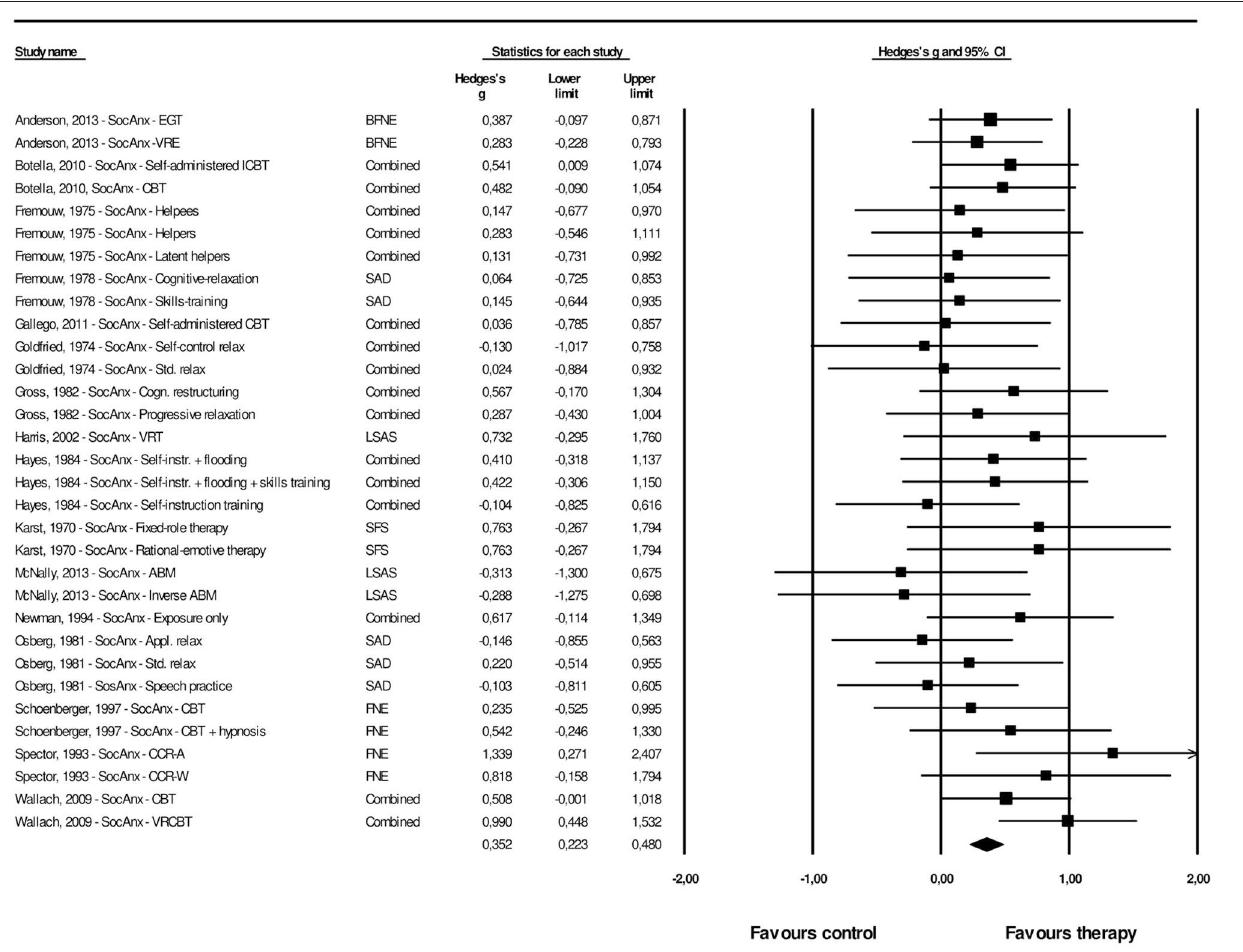
FIGURE 4 | A forest plot of the standardized effect sizes of psychological treatments aimed at FoPS for generalized social anxiety compared with control conditions.